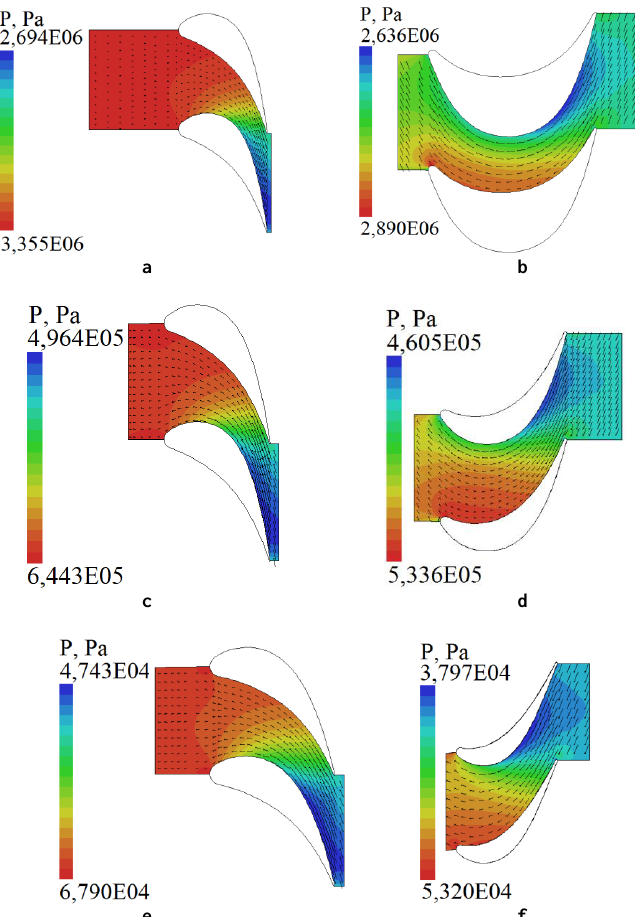
Figure 24: Static pressure contours and velocity vectors in stators and rotors at the mid span blade-to-blade sections of turbine CMP T-125/150-12,8: a – S 1st stage; b – R 1st stage; c – S 8th stage; d – R 8th stage; e – S 14th stage; f – R 14th stage